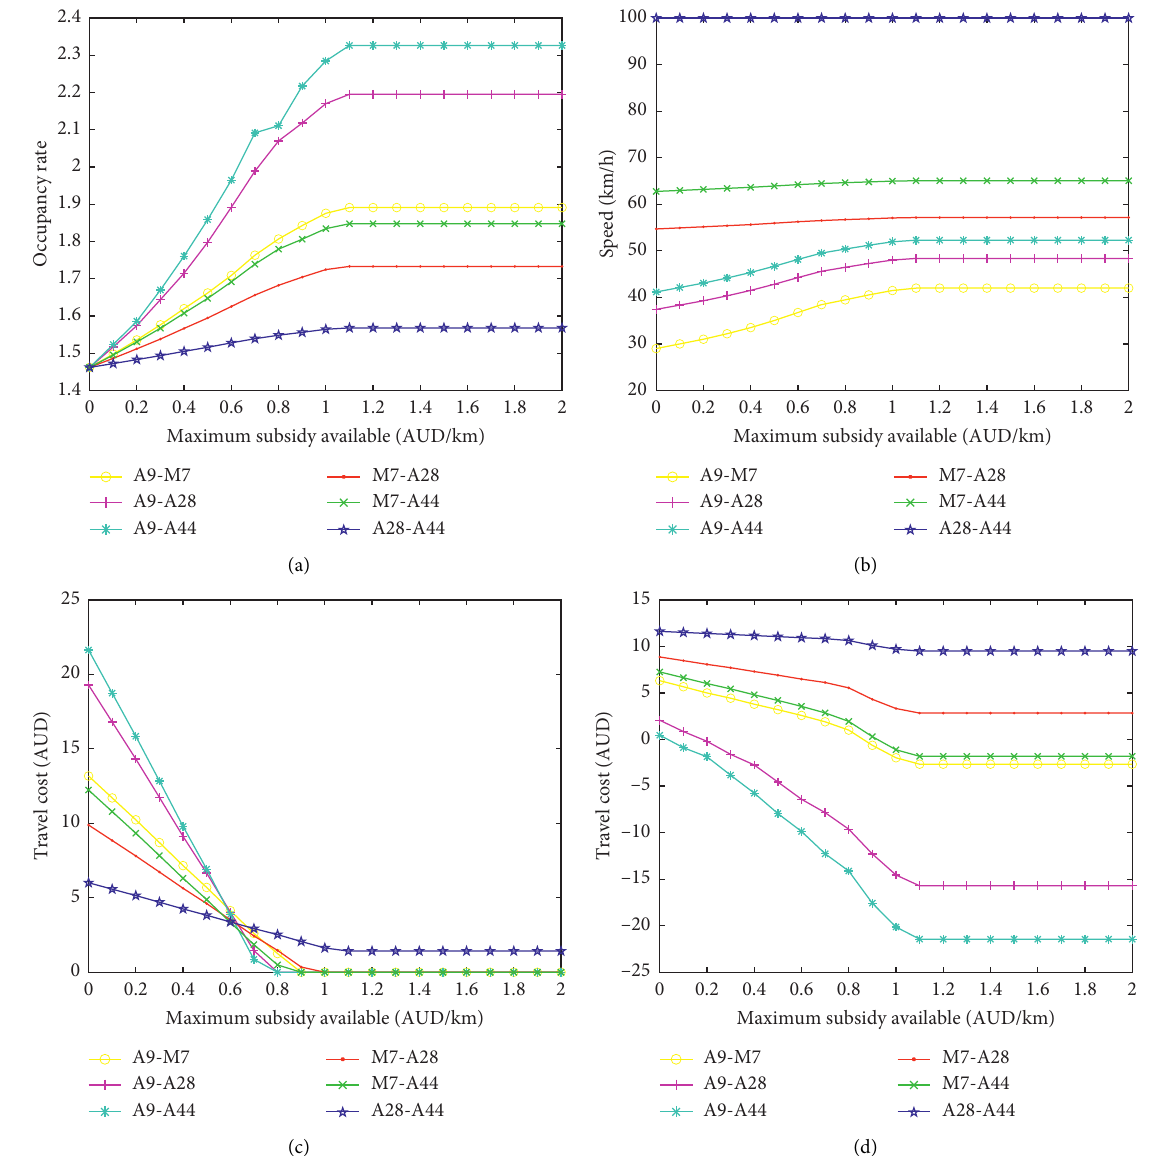
Figure 4: Detailed analysis of the impact of the maximum subsidy available on the 6 main ODs in the network. (a) Vehicle occupancy. (b) Speed. (c) Average RSP travel cost. (d) Average RSD travel